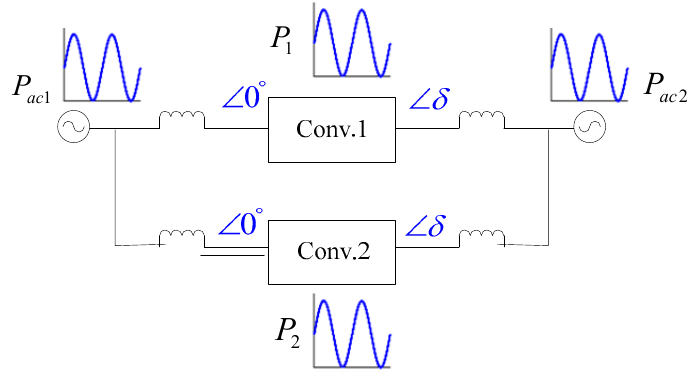
Figure 7. Power fluctuation of single ‐ phase LFAC transmission system.